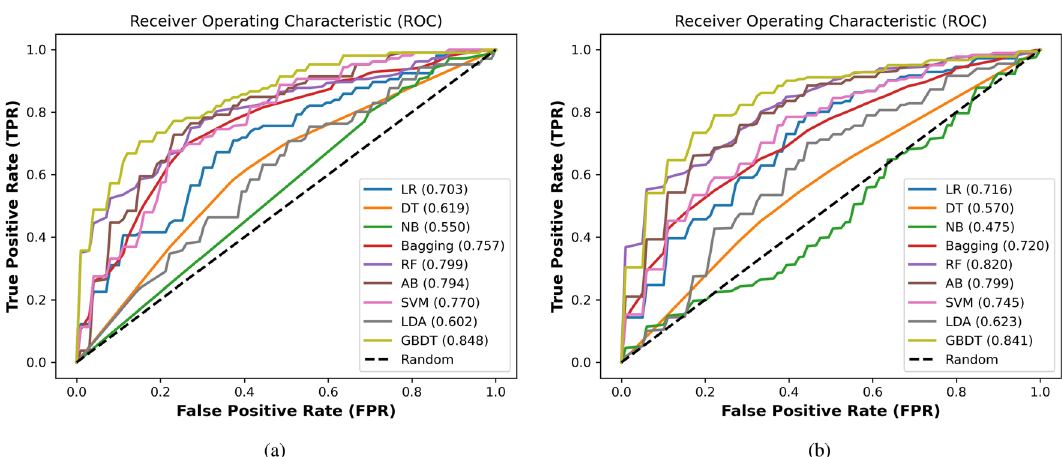
Figure 7. The AUC for the proposed system based on the GBDT compared with state-of-the-art classifiers on the lncRNA dataset with ( a ) 4-fold and ( b ) 10-fold cross-validation techniques.